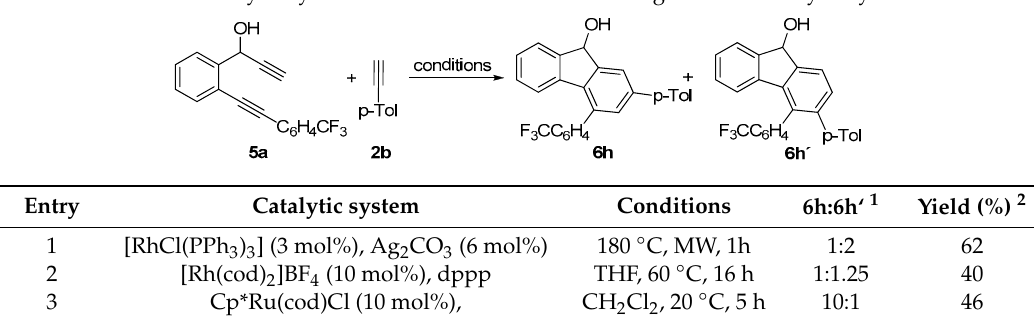
Table 4. Catalytic cyclotrimerization of 5 with various amounts of 2b